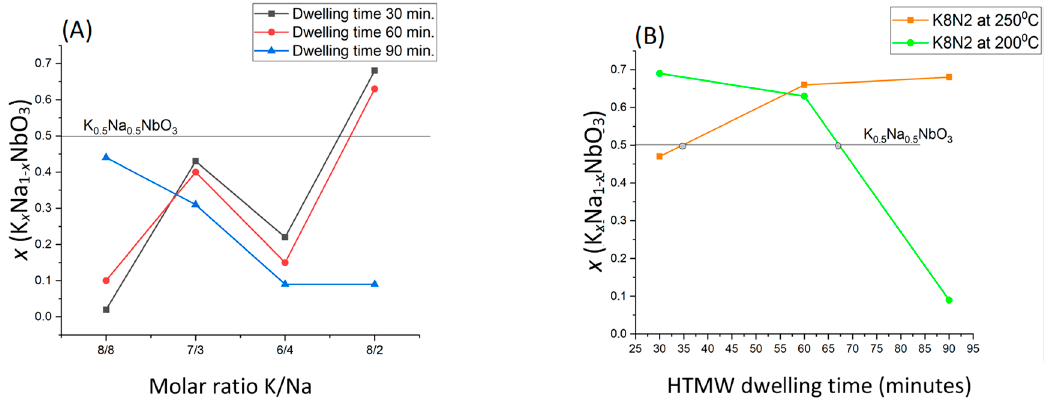
Figure 2. ( A ) Molar fraction x (K x Na 1 ‐ x NbO 3 ) variation depending on alkaline precursor molar rate for the three series of HTMW dwelling time (30, 60 and 90 min) at maximum temperature 200°C; ( B ) Solid solution K x Na 1 ‐ x NbO 3 molar fraction x variation for sample K8N2 (K/Na = 8M/2M) depending on the HTMW temperature 200 °C and 250 °C at the three tested dwelling times (30, 60 and 90 min).